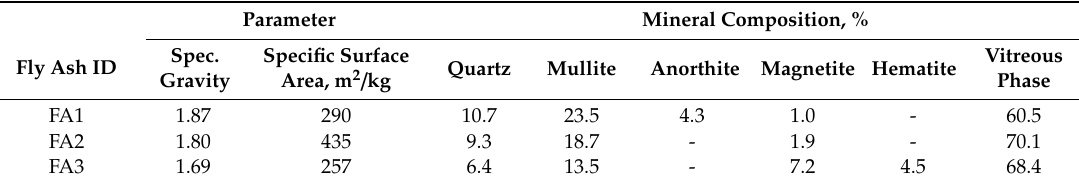
Table 2. Mineral and physical characteristics of the fly ash